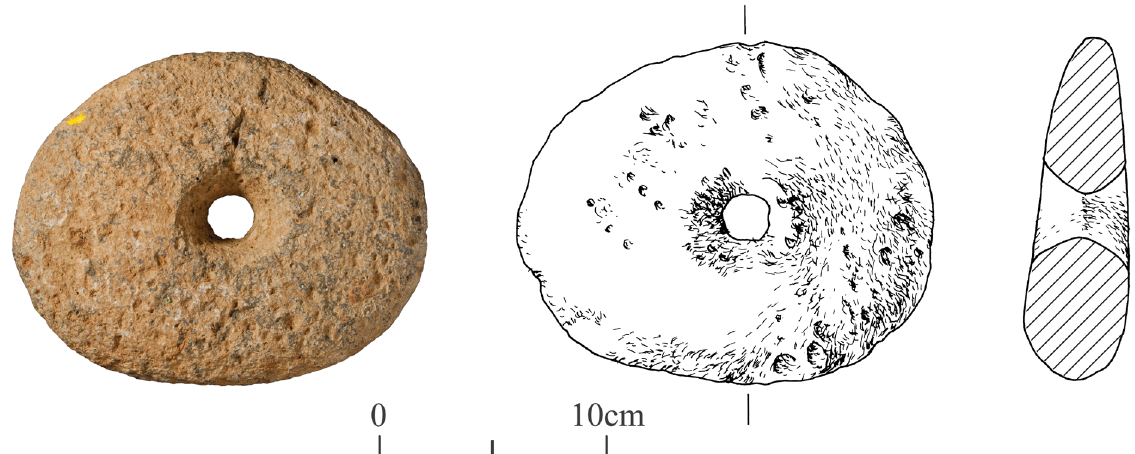
Figure 5. A ground stone perforated disk which is a possible flywheel for a pump drill or a weight for a crank drill; from Tel Dan, Locus 8189 (Stratum V [Iron Age I], Registration number 20672/1), weight: 1.63 Journal of Lithic Studies (2016) vol. 3, nr. 3, p. 261-277 doi:10.2218/jls.v3i3.1642